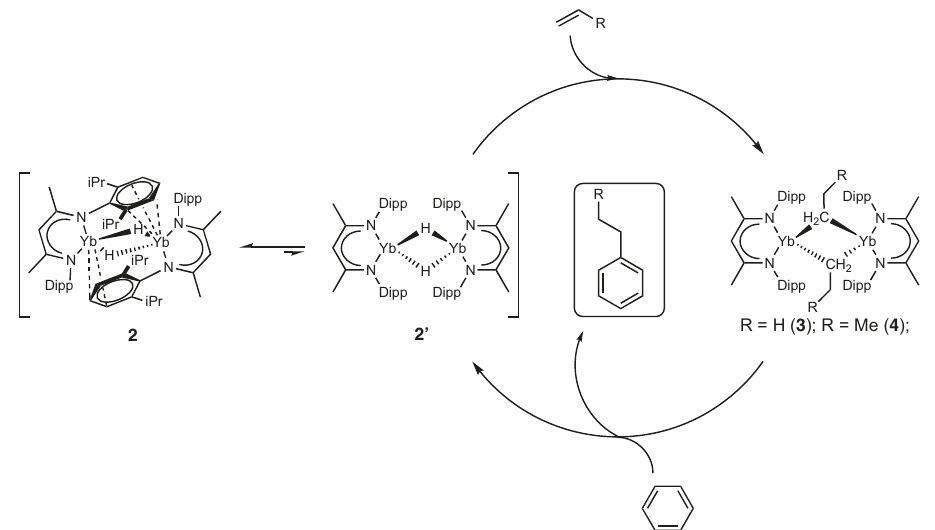
Fig. 6 Proposed catalytic mechanism. Hydrophenylation of ethene and propene with benzene catalysed by 3 and 4 ,